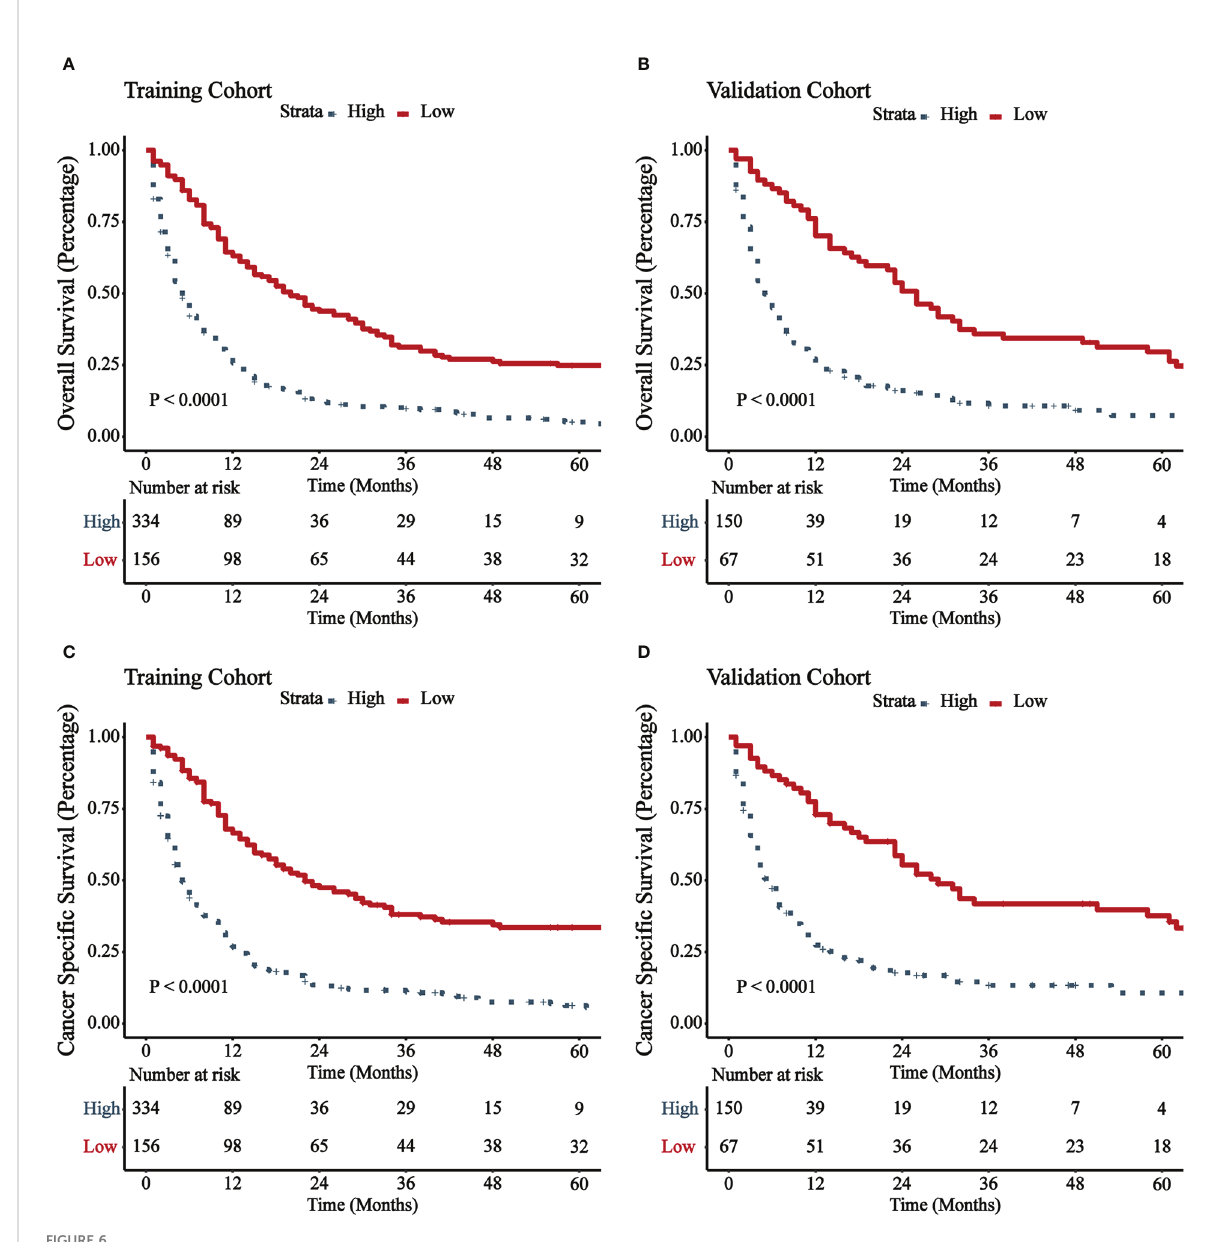
FIGURE 6 K-M survival curves of patients with GBMAC in high-risk group and low-risk group. (A) OS comparison of patients with GBMAC based on risk score grouping in training cohort. (B) OS comparison of patients with GBMAC based on risk score grouping in validation cohort. (C) CSS comparison of patients with GBMAC based on risk score grouping in training cohort. (D) CSS comparison of patients with GBMAC based on risk score grouping in validation